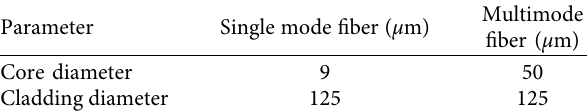
Table 1: List of parameters of fiber optics.